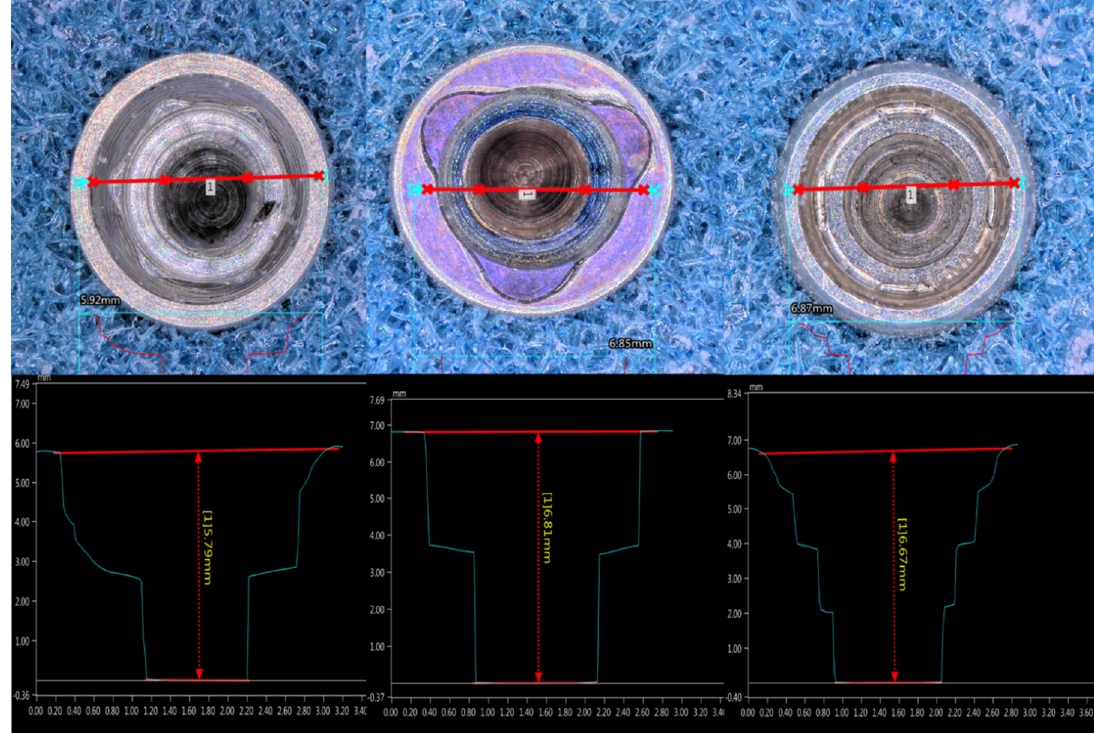
Figure 5. Length of the implant connection. Two points were located at each side of the implant platform. A line was traced from the most upper part of the platform to the lowest part of the connection. The blue lines are showing the internal profile of each connection, which is different in each of them. Group B has the longest connection depth.